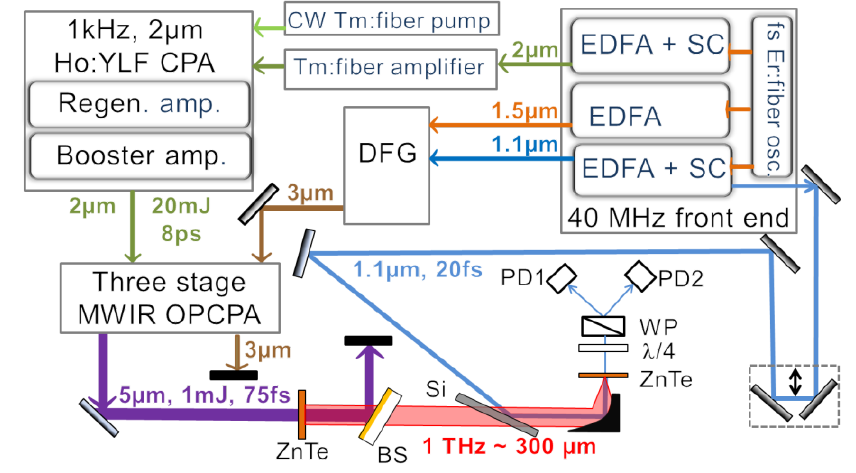
Fig. 1. Setup of the 5 µm driver source and THz generation and detection scheme. The main parts are the front-end, the difference frequency generation (DFG), the 2-µm Ho:YFL CPA amplifiers, the three OPA stages based on ZGP crystals and the THz generation and detection unit. EDFA, Er:fiber amplifier; SC, supercontinuum generation; Regen. Amp., regenerative amplifier; Booster amp., power amplifier; ZnTe, crystal for THz generation and detection; BS Broadband mid-infrared beam-splitter; WP, Wollaston prism; PD, photo diodes.